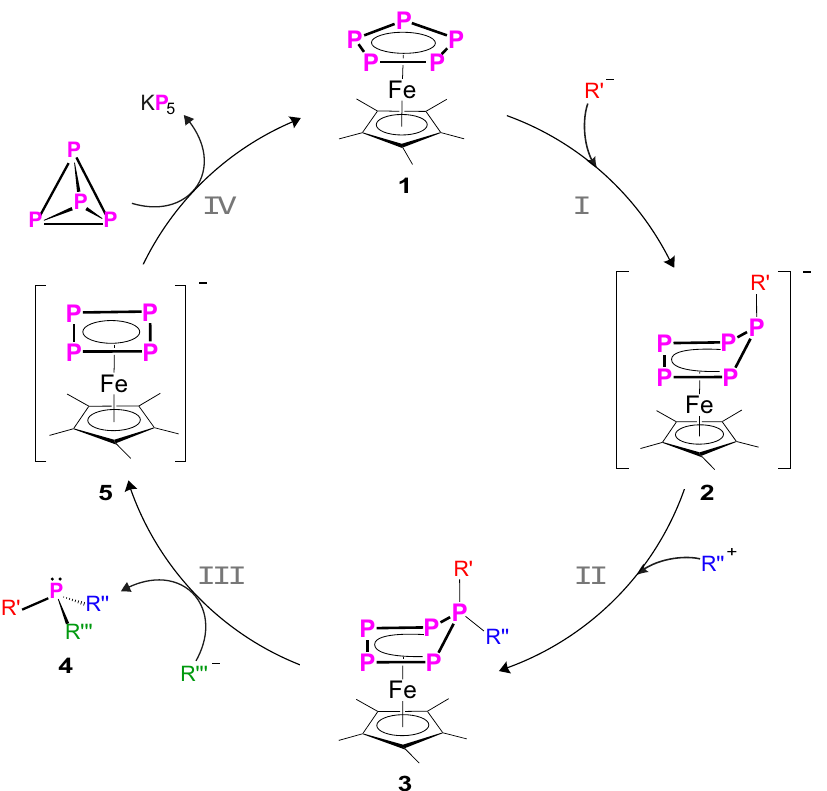
Fig. 6 ‘ Semi-catalytic ’ cycle for the synthesis of asymmetric phosphines. One-pot reaction of [Cp*Fe( η 5 -P 5 )] ( 1 ) with MeLi (I, R ′ = Me), quenching with MeI (II, R ″ = Me), reaction with KBnz (III, R ‴ = Bnz) and subsequent thermolysis with white phosphorus